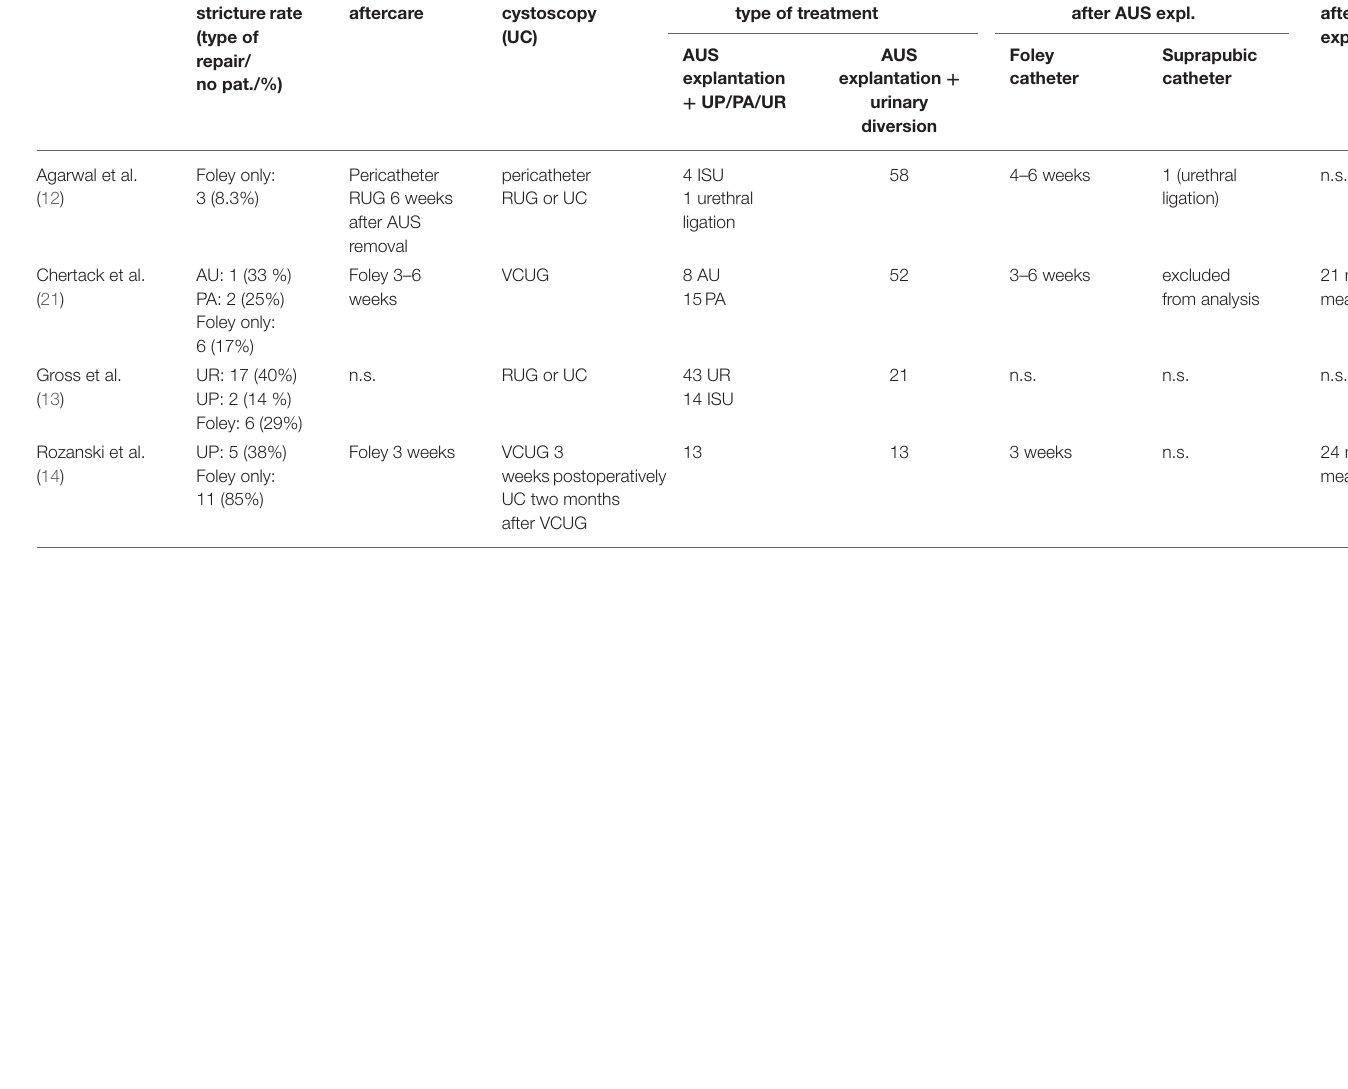
TABLE 3 | Summary of studies reporting management and stricture rates of AUS explantation in case of urethral erosion.